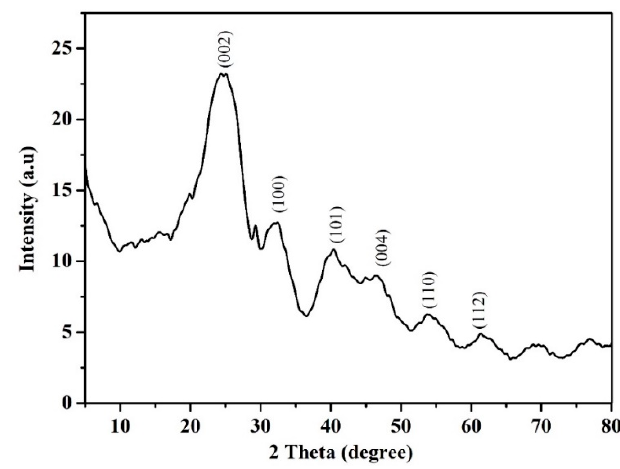
Figure 4. XRD (X-ray diffraction) pattern for hybrid CNTs.